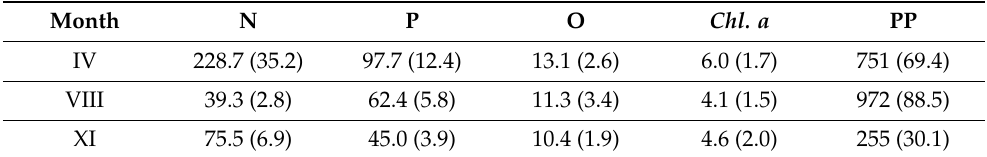
Table 1. Baltic Sea trophic state parameters; mean (standard deviation); N, P, O biogenic